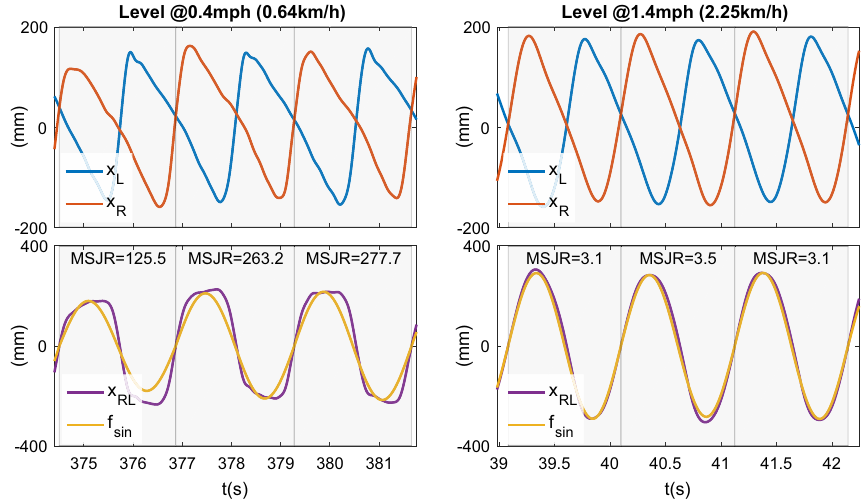
Figure 2. Example of left ( x L ) and right ( x R ) foot position time evolution for two speeds, in level ground walking. The relative position between both feet, x RL is taken to compute the MSJR with respect to a sine wave, f sin , a maximally smooth rhythmic movement.